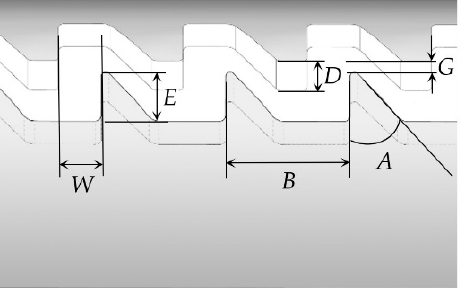
Figure 4. Structural perspective of the flow channel in variable flow emitter.